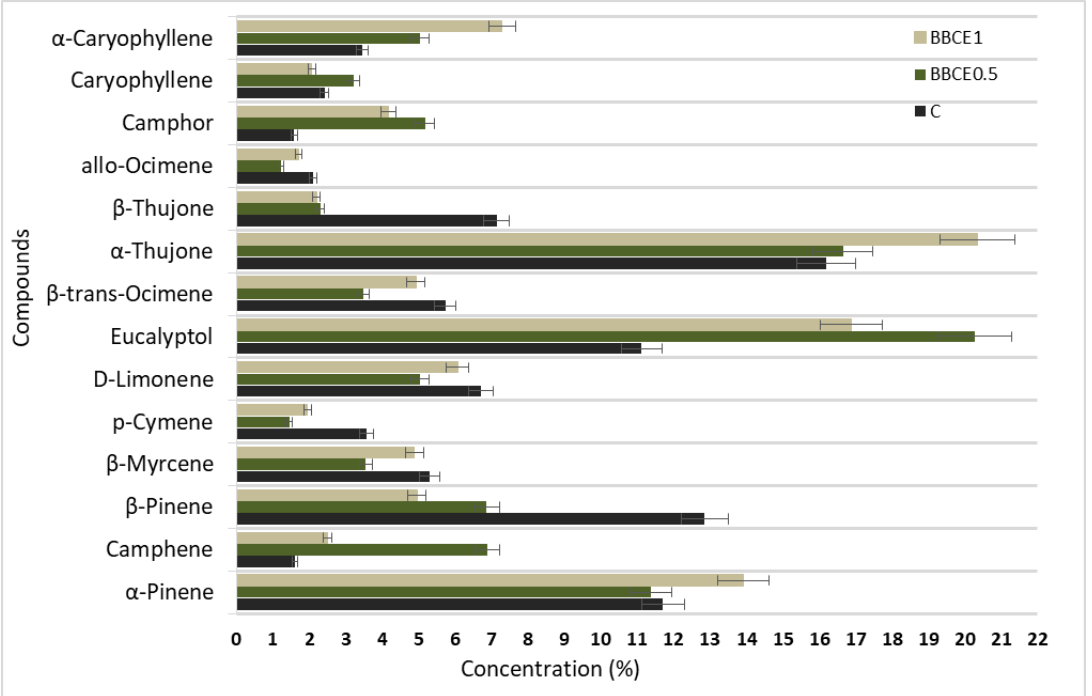
Figure 5. Representative graphic for concentrations (peak area percent) of the main volatile compounds from Salviae folium, obtained by GC-MS method. Error bars represent the standard deviations of means. C — Control; BBCE0.5 — beech bark crude extract 0.5 g bark/100 mL extract; BBCE1 — beech bark crude extract 1 g bark/100 mL extract.